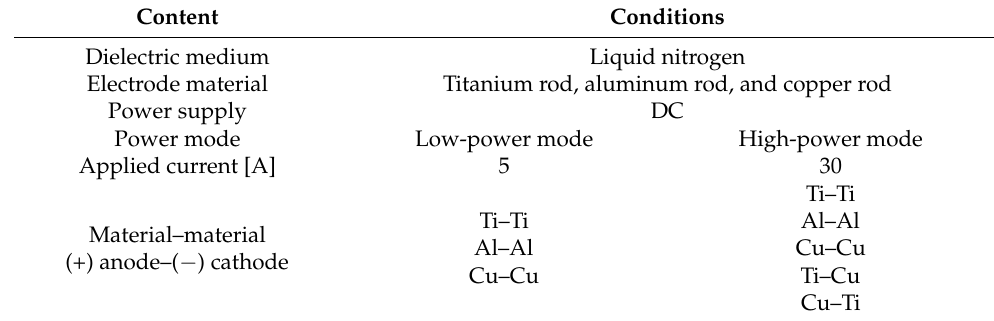
Table 1. Detailed operating conditions.